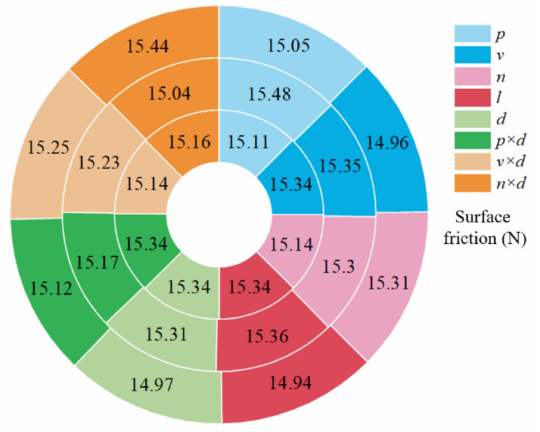
Figure 10. Range analysis of the average frictional force on the surface of the